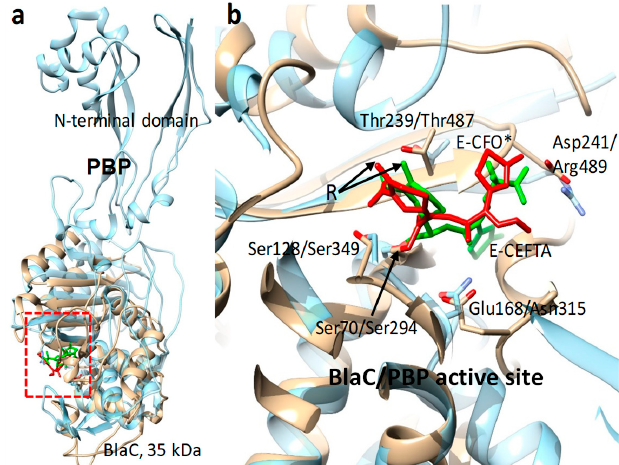
Figure 5. Structural comparison of penicillin ‐ binding protein (PBP, blue, PDB entry 3OCN) and M. M. tuberculosis β -lactamase (BlaC; brown, PDB entry 6B69). ( a ) Overall view: BlaC is tuberculosis β‐ lactamase (BlaC; brown, PDB entry 6B69). ( a ) Overall view: BlaC is structurally very